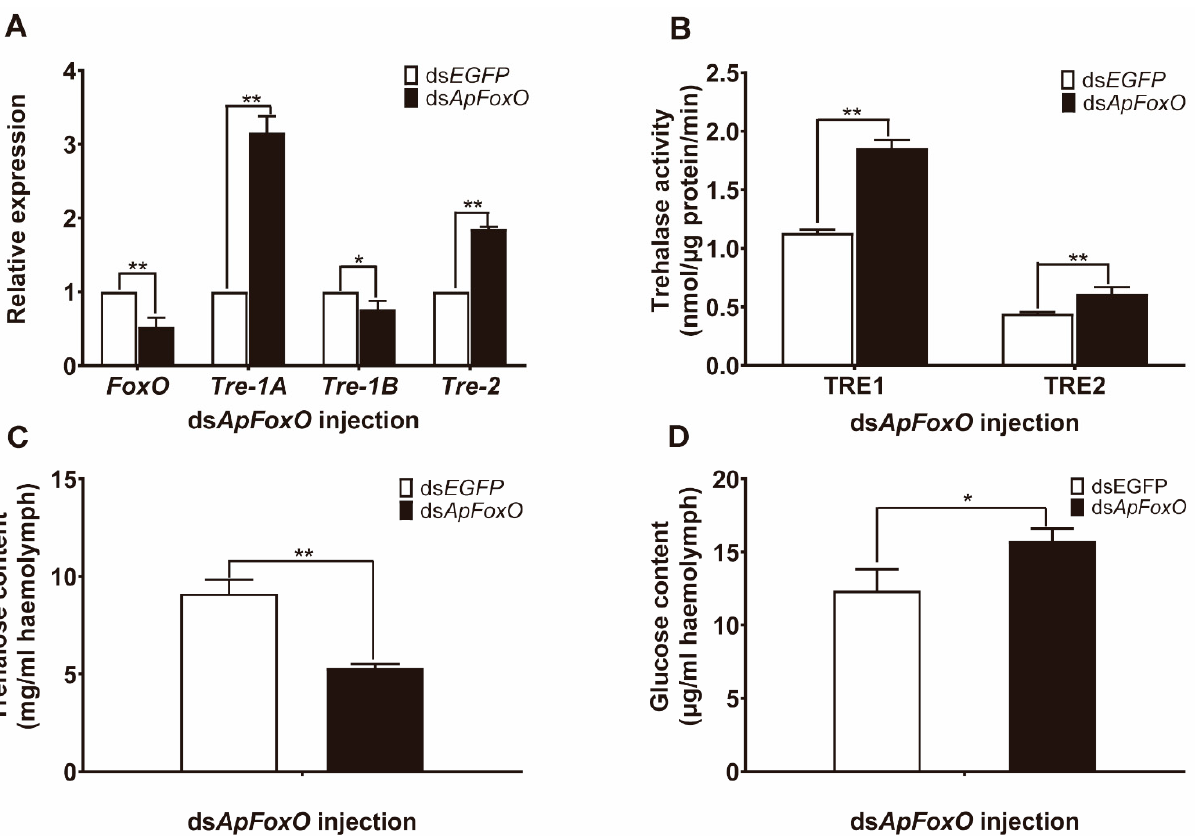
Figure 5. Effects of ApFoxO -specific RNAi on trehalose metabolism in diapausing A. pernyi pupae. ( A ) Relative expression levels of ApFoxO , ApTre-1A , ApTre-1B , and ApTre-2 at 48 h after ds ApFoxO injection in comparison to controls (ds EGFP injection). ( B ) Changes in soluble (TRE1) and membrane-bound (TRE2) trehalase activity caused by ds ApFoxO or ds EGFP treatment at 48 h post-injection. ( C , D ) Changes in trehalose and glucose content, respectively, in the haemolymph at 48 h post-injection. mRNA levels were normalised to those of the reference genes actin and RP49 , and the group injected with ds EGFP served as controls. Data are means of three independent experiments, and error bars are SEs. Single asterisks ( p < 0.05) and double asterisks ( p < 0.01) represent significant differences between the ds EGFP and ds ApFoxO groups in the same time period.